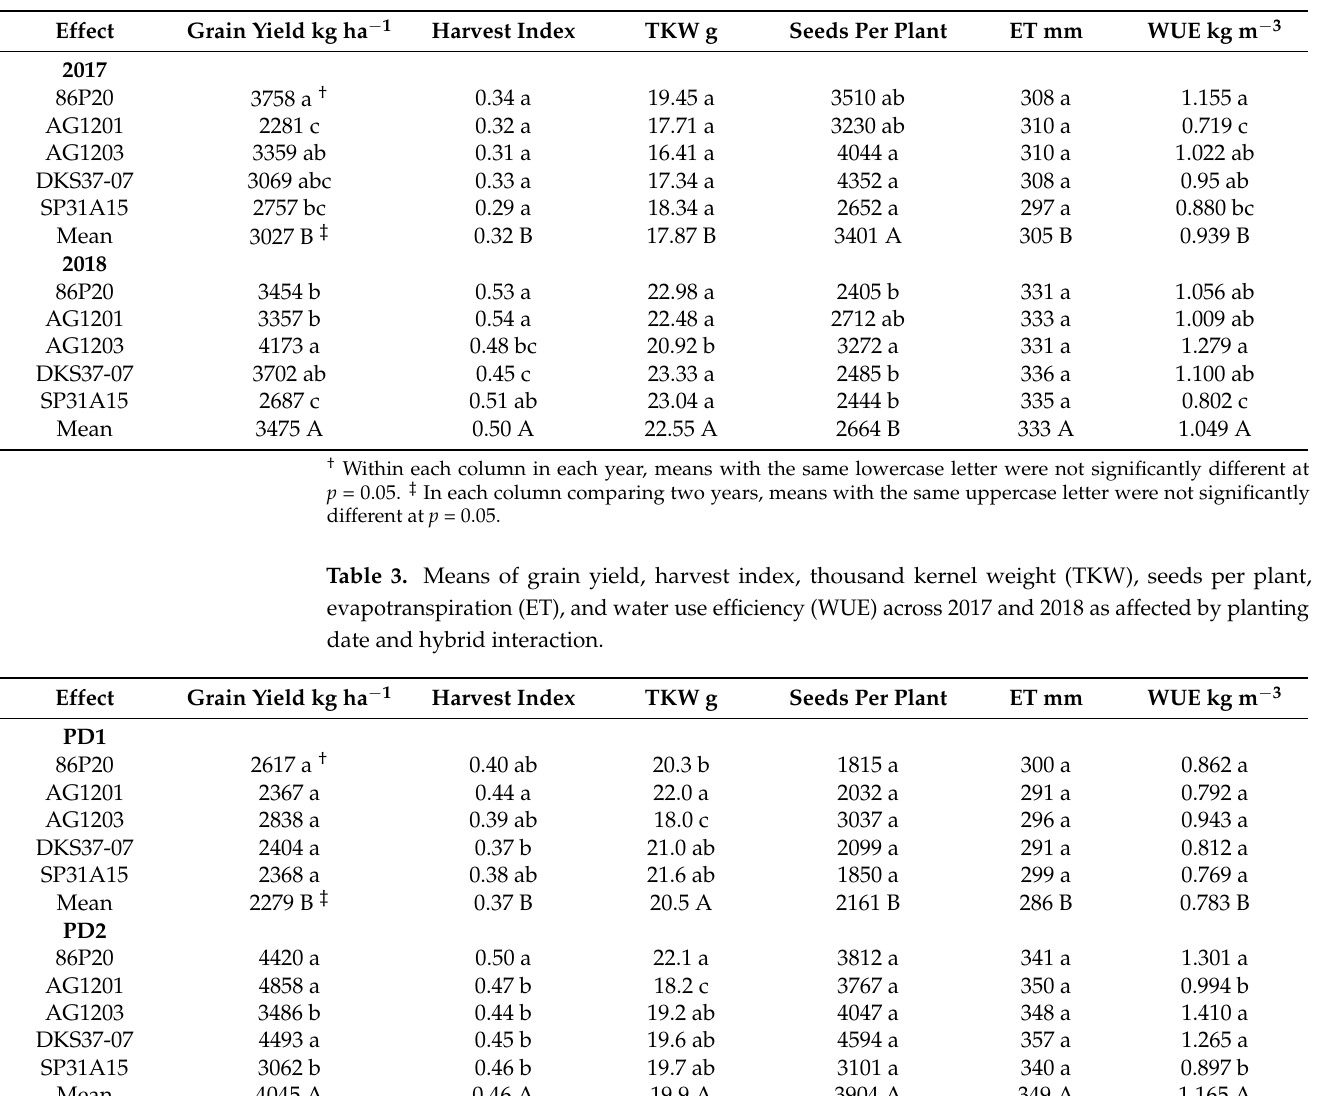
milk stage. In comparison, SCAs did not arrive until after grain sorghum in 2017 PD1 reached physiological maturity, and in 208 PD1, SCAs peaked at soft dough and declined to physiological maturity depending on the hybrid. A regression analysis for PD2 showed that there was a negative relationship between grain yield and SCA per leaf for both 2017 (R 2 = 0.42, p = 0.00194) (Figure 4A) and 2018 (R 2 = 0.42, p = 0.00426) (Figure 4B). In the PD1 of 2018, the SCA infestation was observed at the grain-filling stage and did not affect grain yield (R 2 = 0.02, p = 0.4533; data not